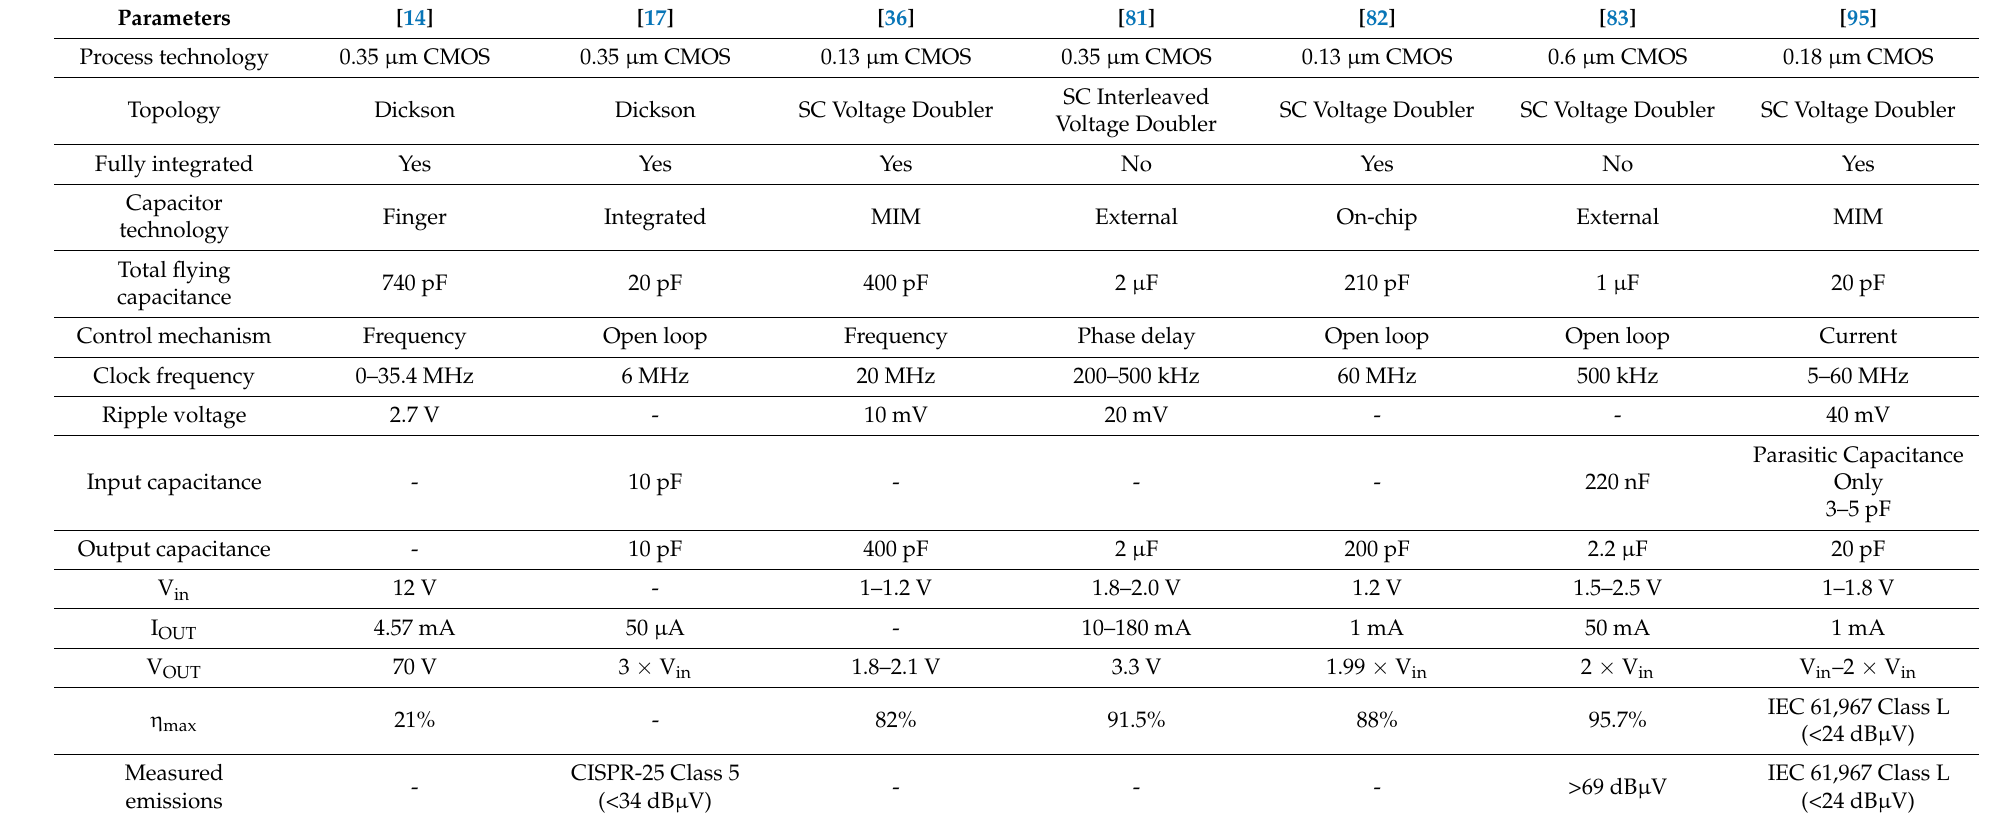
Table 5. Performance comparison of various topologies based on